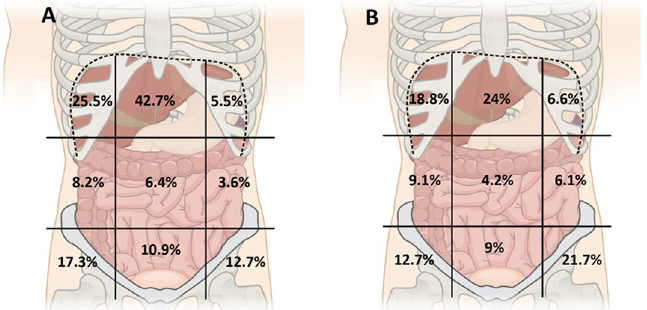
Figure 2. Localization of abdominal pain. ( A ) abdominal pain on history. ( B ) abdominal point tenderness (each percentages represented the frequency of pain in the concerned region independently from the other localizations). (Adapted from Abdominal Quadrant Regions Cleaned, Jmarchn. Creative Commons Attribution- Share Alike 3.0 Unported).